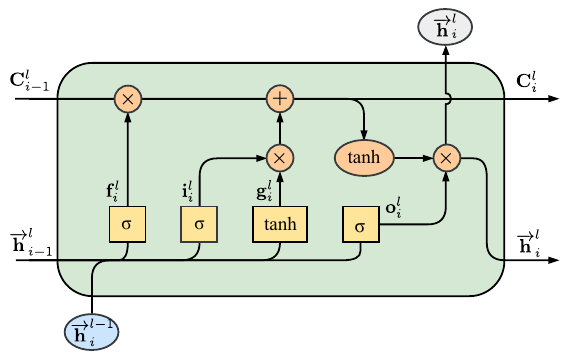
Figure 1. Detailed structure within an LSTM cell in the forward direction.